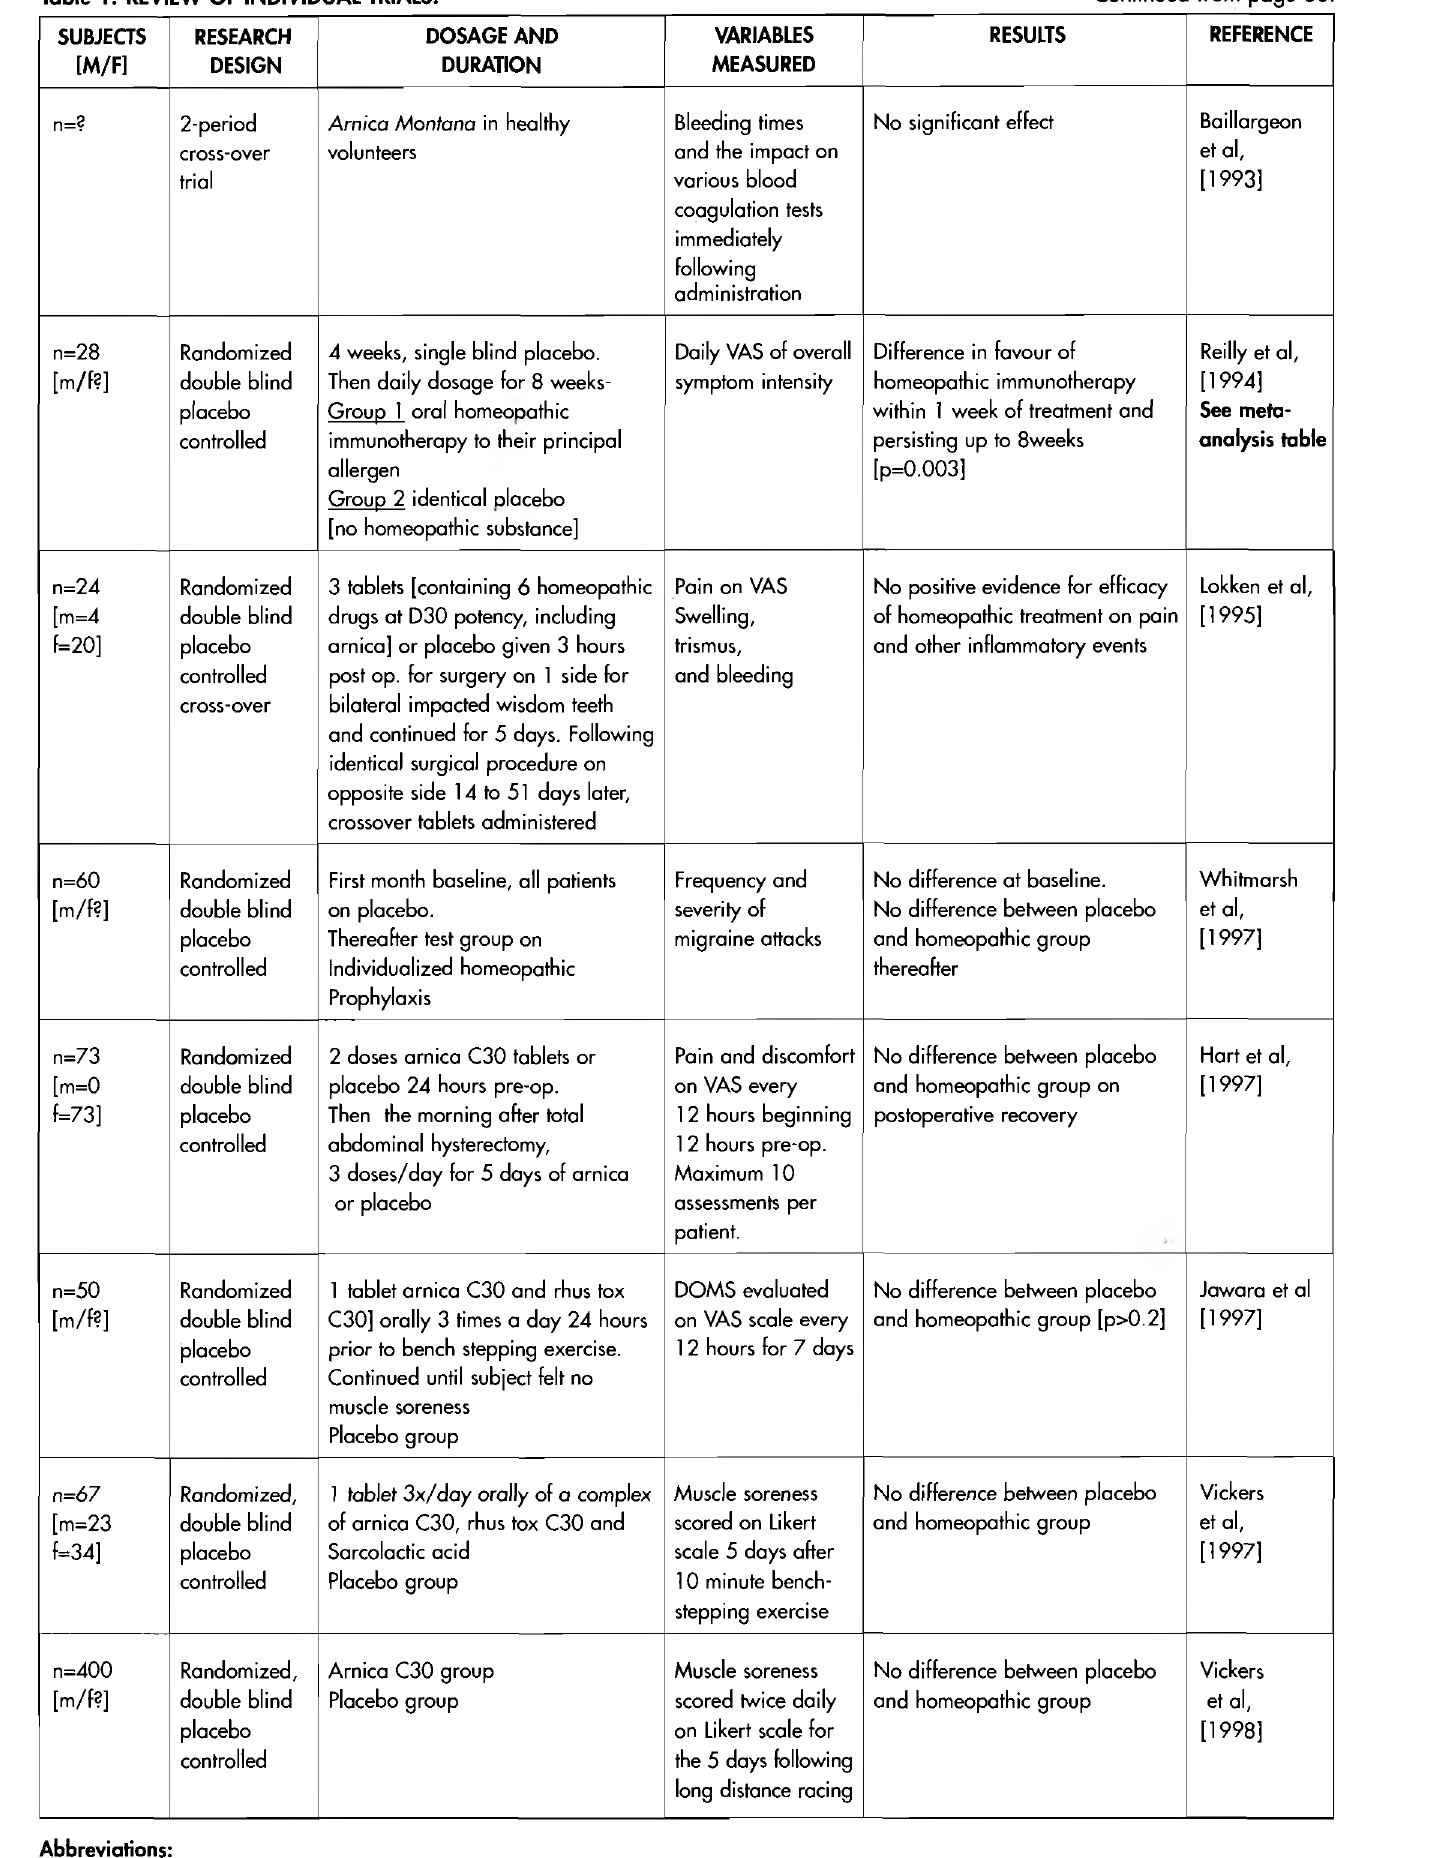
Table 1: REVIEW OF INDIVIDUAL TRIALS. ► Continued from page